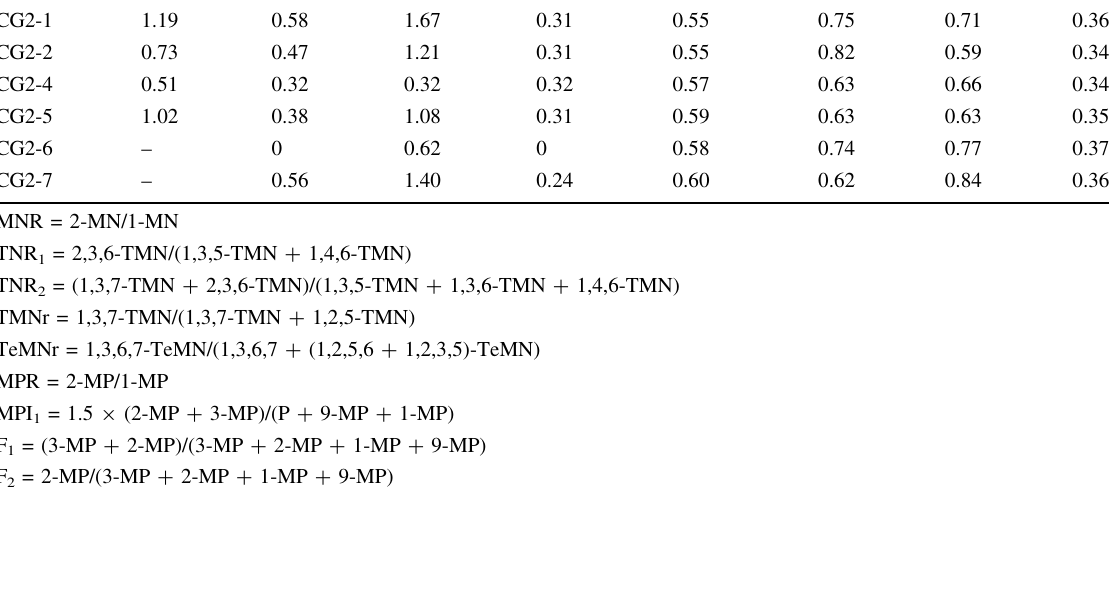
Table 4 Organic geochemical parameters of aromatic hydrocarbons Sample